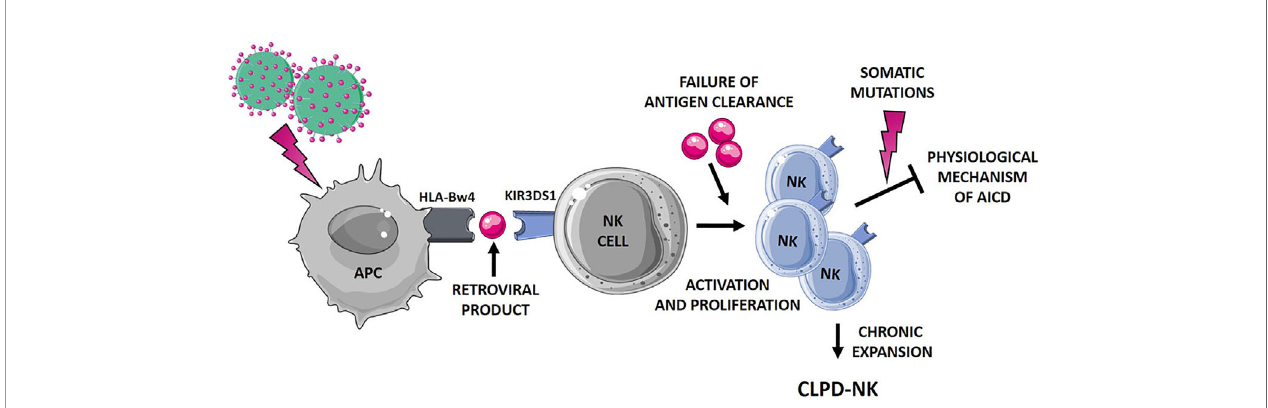
FIGURE 2 | Hypothetical mechanisms favoring NK cell proliferation leading to CLPD-NK. The fi rst step of NK cell activation and proliferation can be related to chronic retroviral stimulation. NK cells, which mostly express the activating KIR3DS1, might interplay with antigen presenting cells (APC). According to literature (31), a small peptide, as a retroviral product, might be involved in this interaction. The failure of antigen clearance might lead to the maintenance of an aberrantly activated NK cell clone, resistant to the physiological mechanism of activation induced cell death (AICD). Additional events, such as the occurrence of somatic mutations (13), can further promote NK cell survival, leading to the establishment of a chronic expansion of clonal NK cells. APC, antigen presenting cells; AICD, activation induced cell death. The fi gure was created using Smart Servier Medical